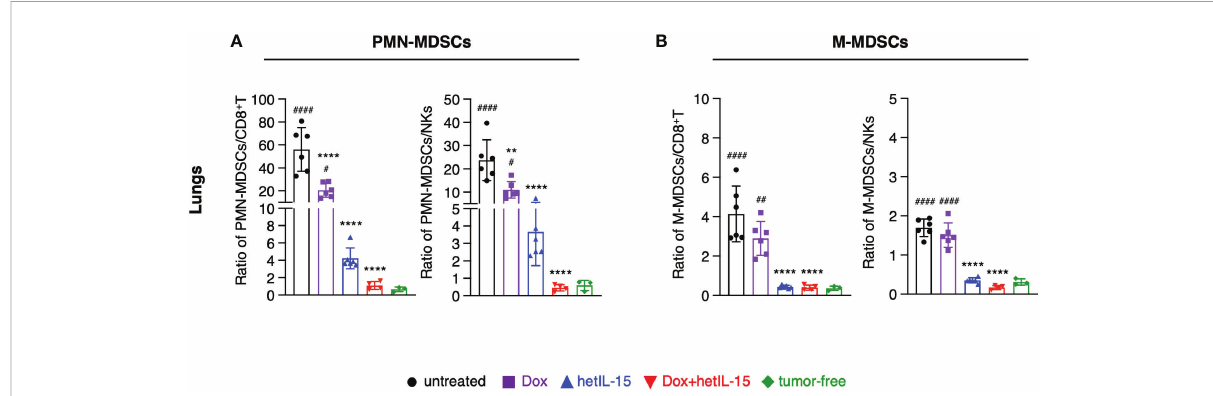
FIGURE 4 hetIL-15 alone and in combination with doxorubicin decreases the suppressor/effector ratios in the lungs. Ratio of (A) PMN-MDSCs to CD8 + T (left) or NKs (right) and (B) M-MDSCs to CD8 + T (left) or NKs (right) in the lungs of each group. Mice were treated following the